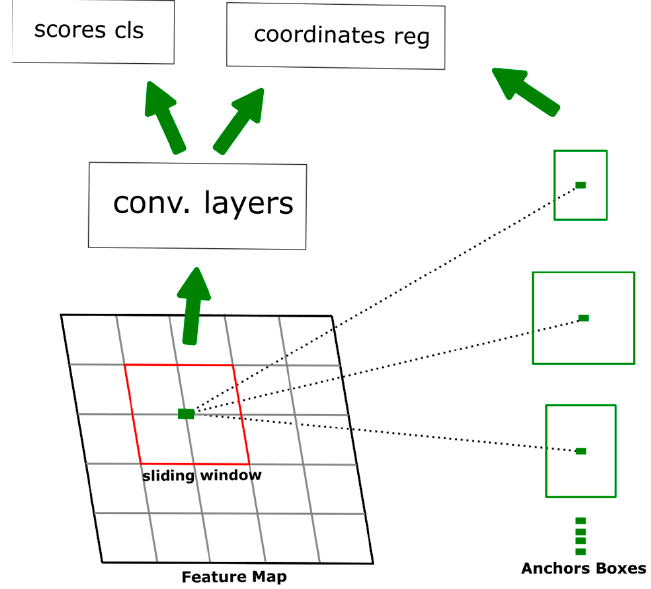
Figure 7. Region Proposal Network (adapted from [8]).